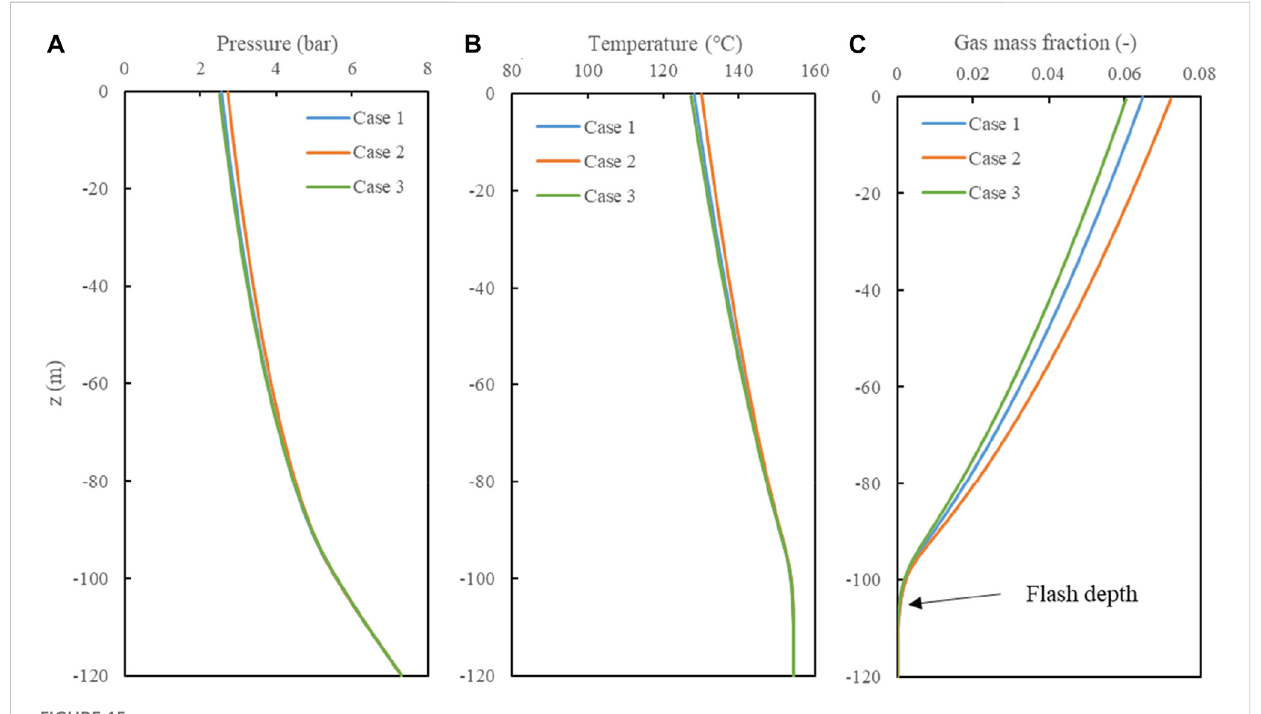
FIGURE 15 Effect of calculation parameters based on ZK304.